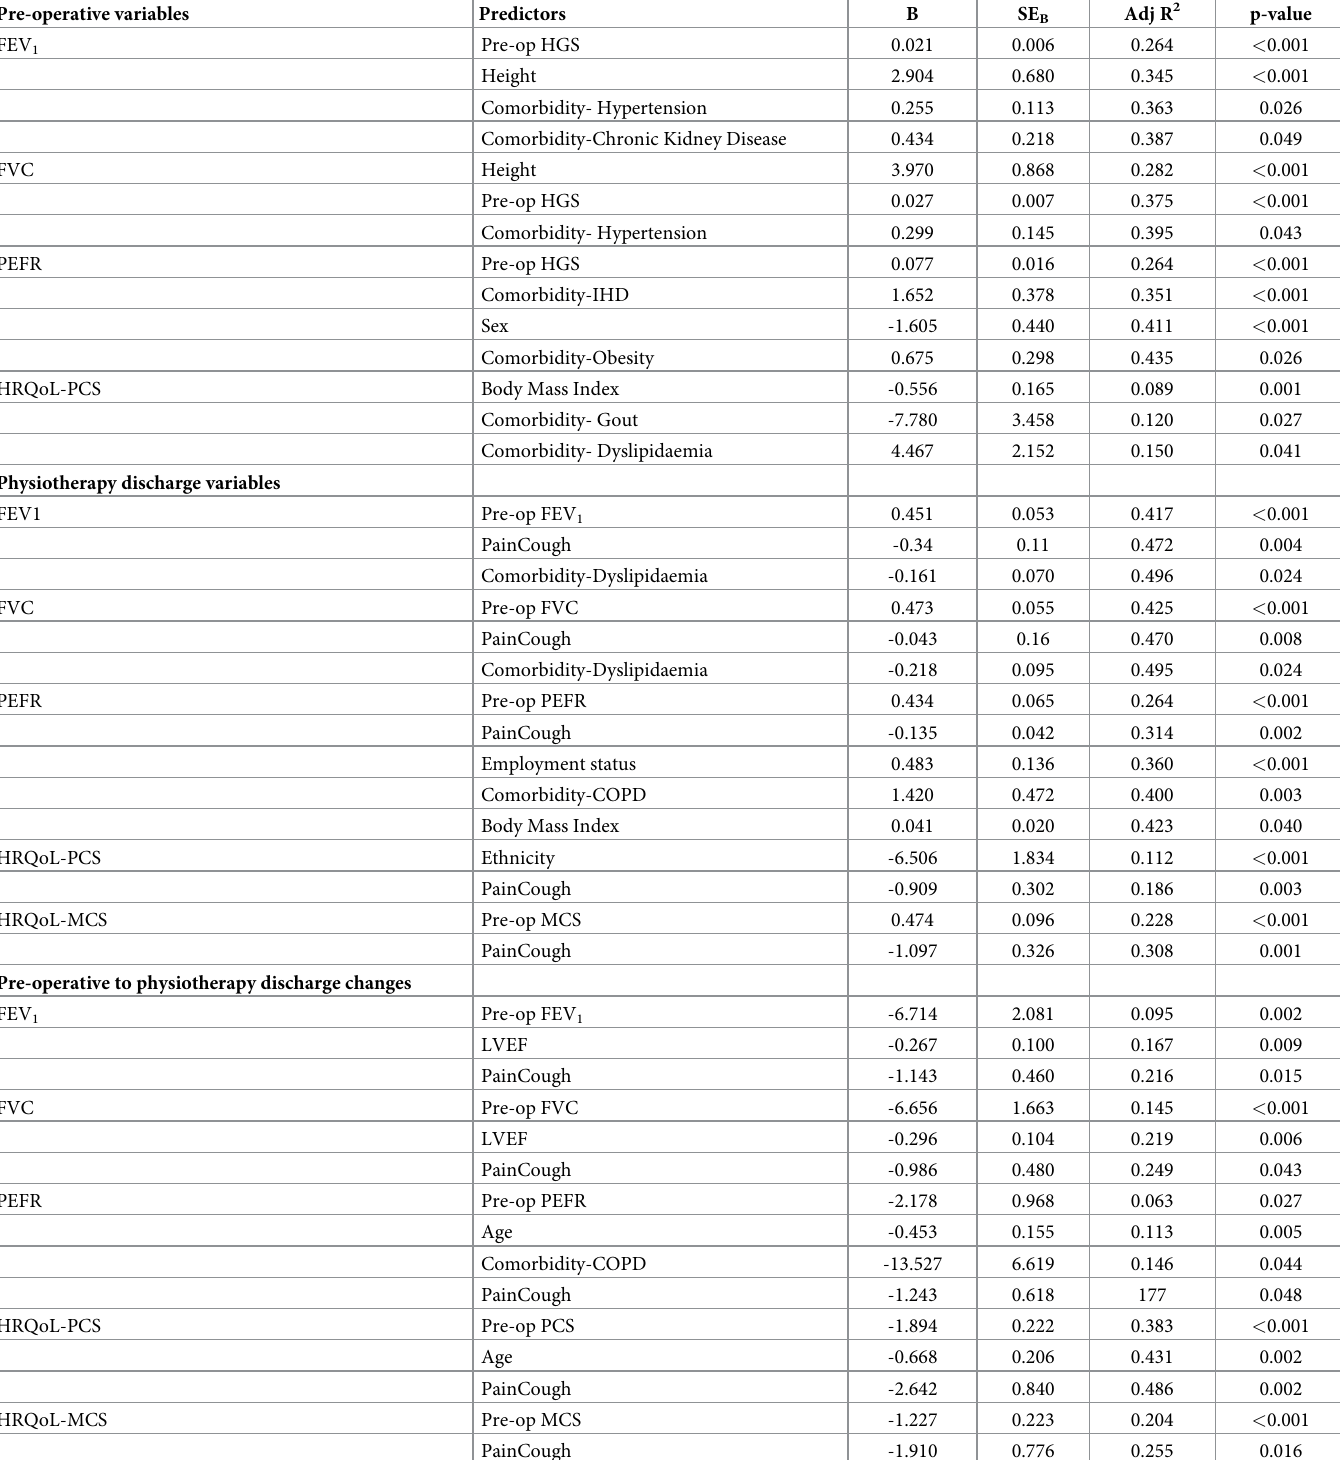
Table 4. Regression variables for lung function and health-related quality of life using handgrip strength and other